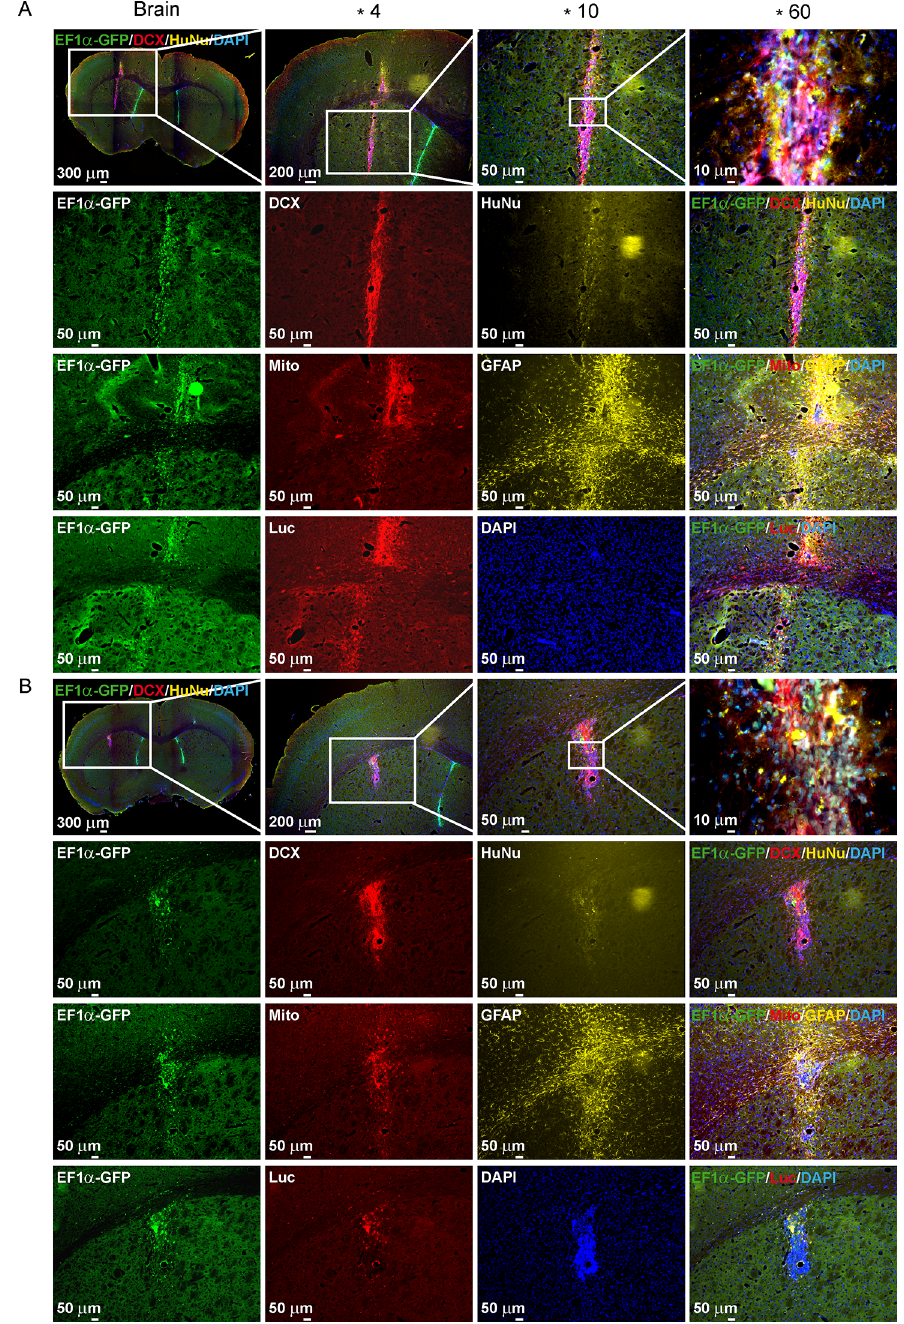
Fig 6. Immunohistochemistry validation of grafted hNSCS. Histology of transplanted H9-EF1-Luc2-GFP cells either labeled with 19 F (n = 4) (A) or unlabeled (n = 4) (B) 9 days after transplantation. An overview of the mouse brain slice (scale bar: 400 μ m) and higher magnification of the grafted cells verified the localization of the transplanted cells (4x magnification, scale bar: 200 μ m / 10x magnification, scale bar: 50 μ m / 60x magnification, scale bar: 10 μ m). GFP-transgene expression (green) and immunostainings with antibodies against: DCX, neuronal marker; HuNu, human nuclei marker; Mito, human mitochondria; GFAP, astrocyte marker; Luc, luciferase